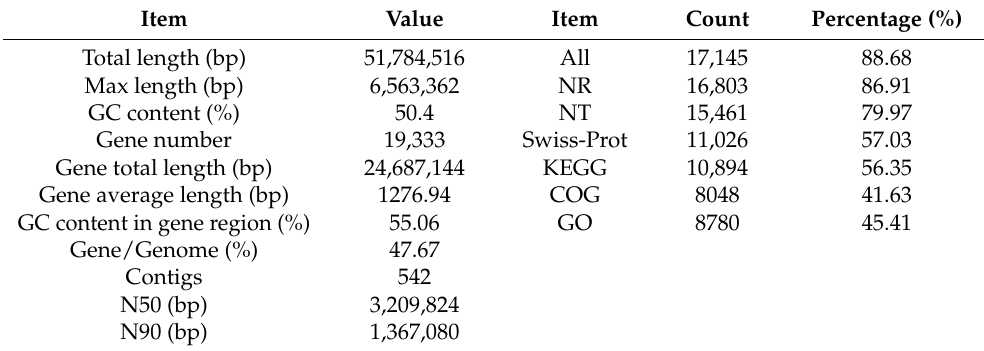
Table 1. Genomic assembly and functional annotation of strain R1 genome.